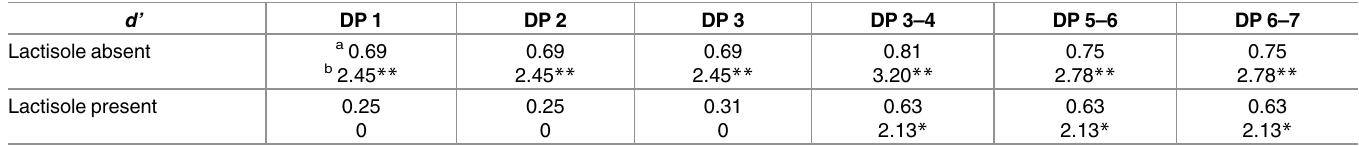
Table 2. Proportion correct a and discriminability ( d’ value) b of target stimuli in the absence and presenceof lactisole.